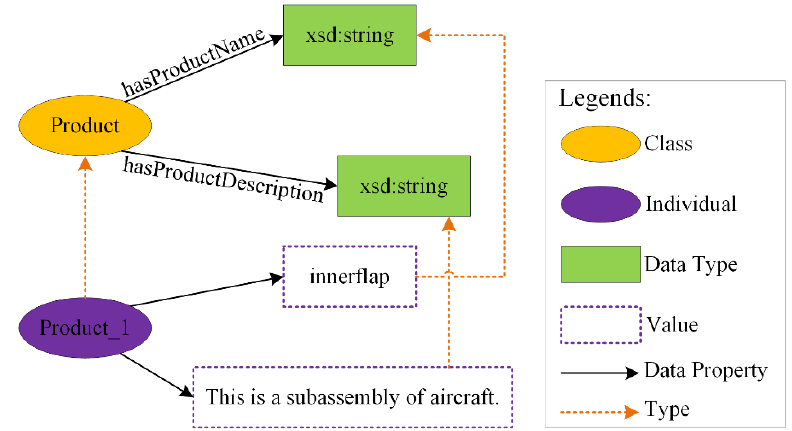
Figure 5. Relationships between instance, class, and property.